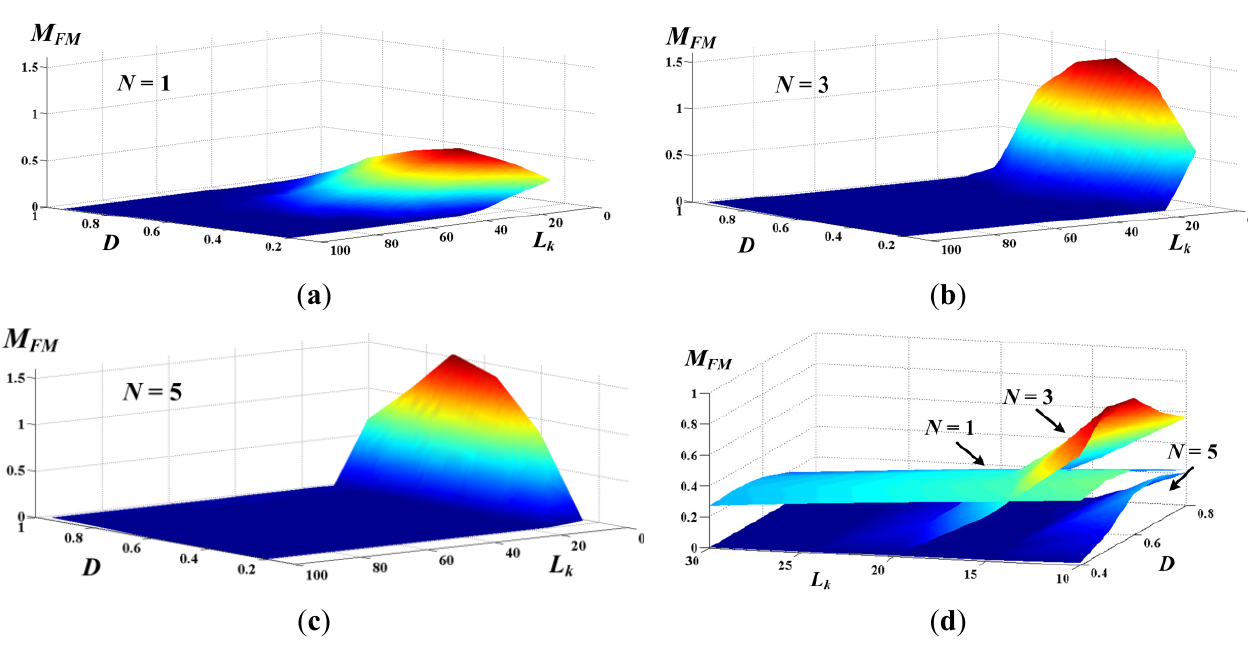
Figure 15. Relationship of M FM and N , D , L k . ( a ) case of N = 1; ( b ) case of N = 3; ( c ) case of N = 5; ( d ) case of chosen